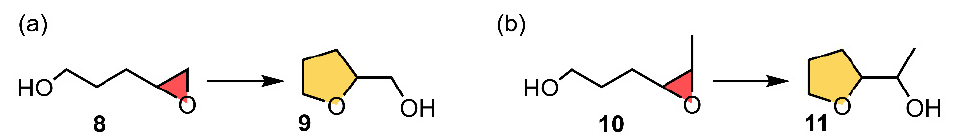
Figure 6. Schematic representation of two epoxide-opening ether cyclizations studied by Hao and collaborators [94] yielding compounds (a) 9 and (b) 11 .